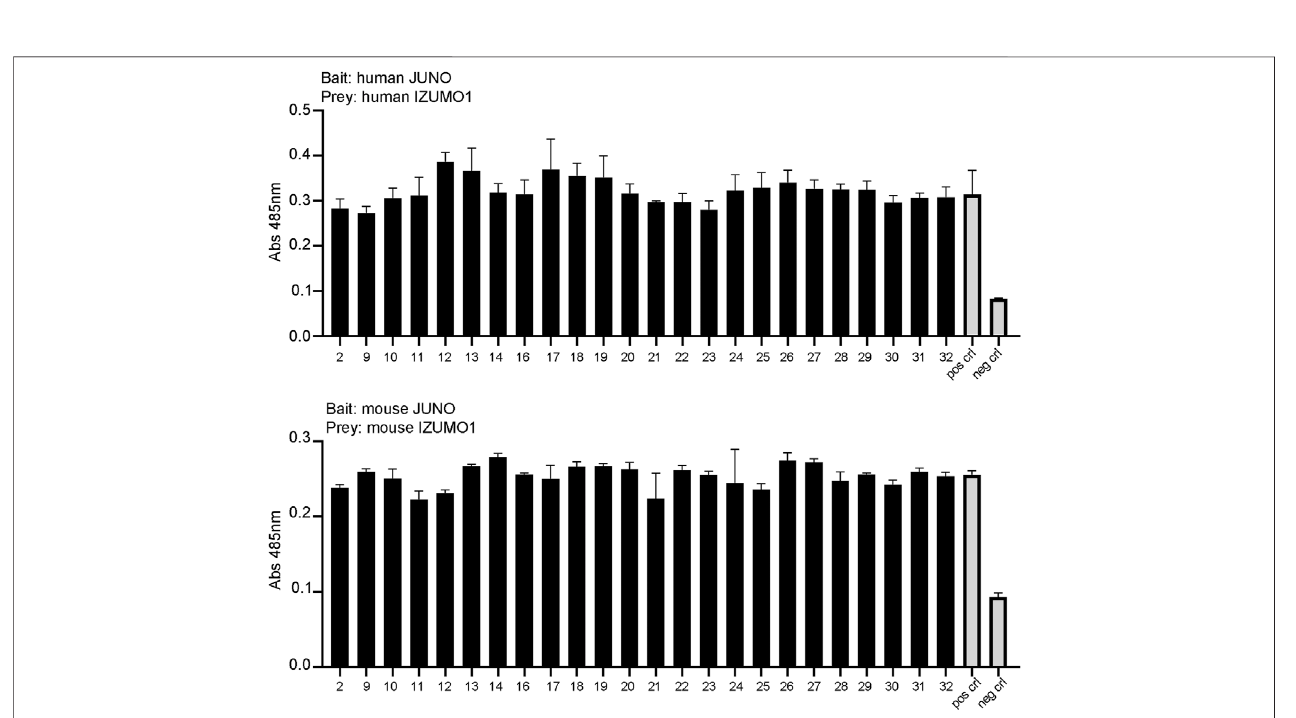
FIGURE 6 | The small molecules tested by AVEXIS did not show the ability to interfere with JUNO – IZUMO1 binding. The soluble ectodomains of JUNO and IZUMO1 were expressed as biotinylated bait and pentameric preys, respectively. Biotinylated JUNO was immobilized on a streptavidin-coated plate and probed for the ability to bind the beta-lactamase-tagged prey IZUMO1. The candidate molecules were incubated with the baits and with the preys at a concentration of 100 μ M while DMSO wasaddedtopositiveandnegativecontrols.Thesameconcentrationwasmaintainedinallstepsoftheassay.Thebindingofbaitsandpreyswasdetected bytheenzymaticturnover ofacolorimetric substrate andquanti fi edbyabsorbancereadings.Noneofthesmall moleculessigni fi cantlyaffectedthebindingofJUNOand IZUMO as shown by the AVEXIS performed with human (upper panel) and mouse (lower panel) proteins.